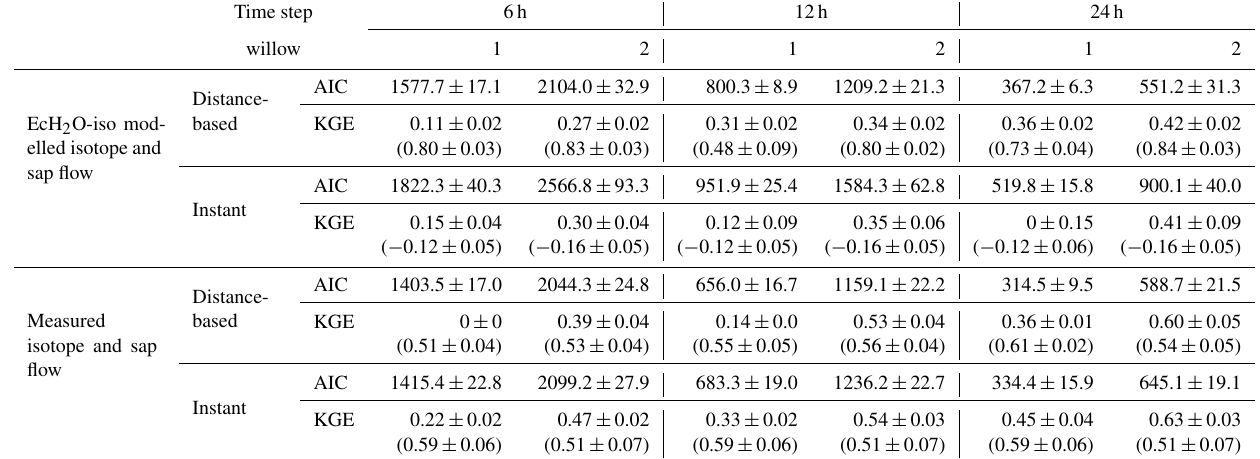
Table 4. Akaike information criteria (AIC) and average KGE ( ± standard deviation) for model performance for each willow evaluated at different time steps. Values in round brackets for KGE show the KGE of sub-daily variability. Mixing models used either output (isotope